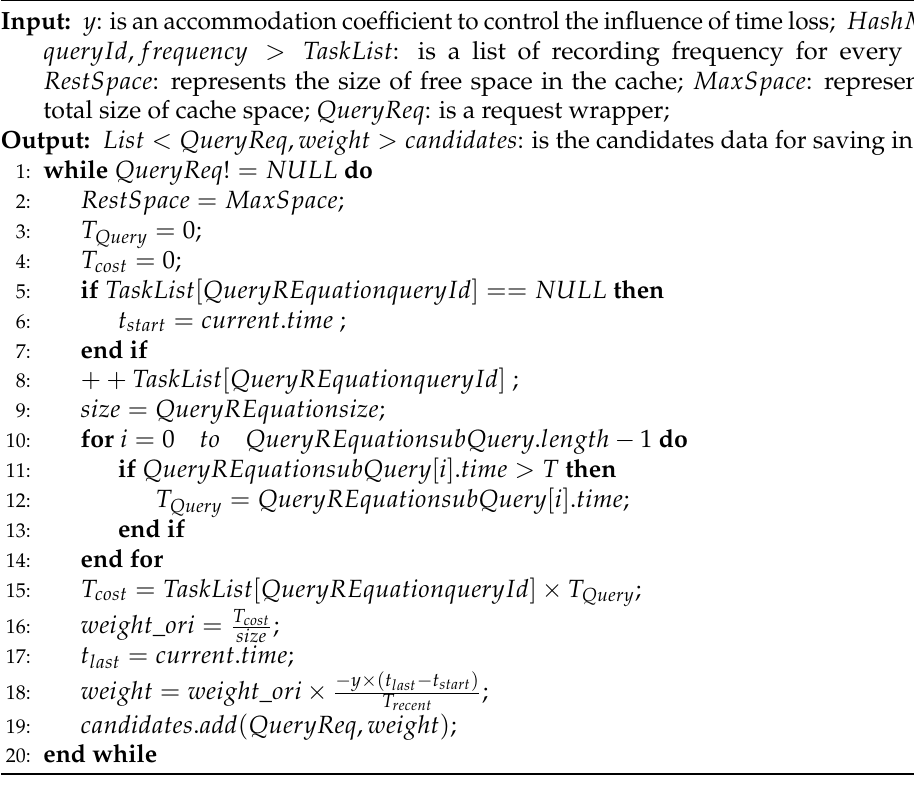
Algorithm 1 CWG